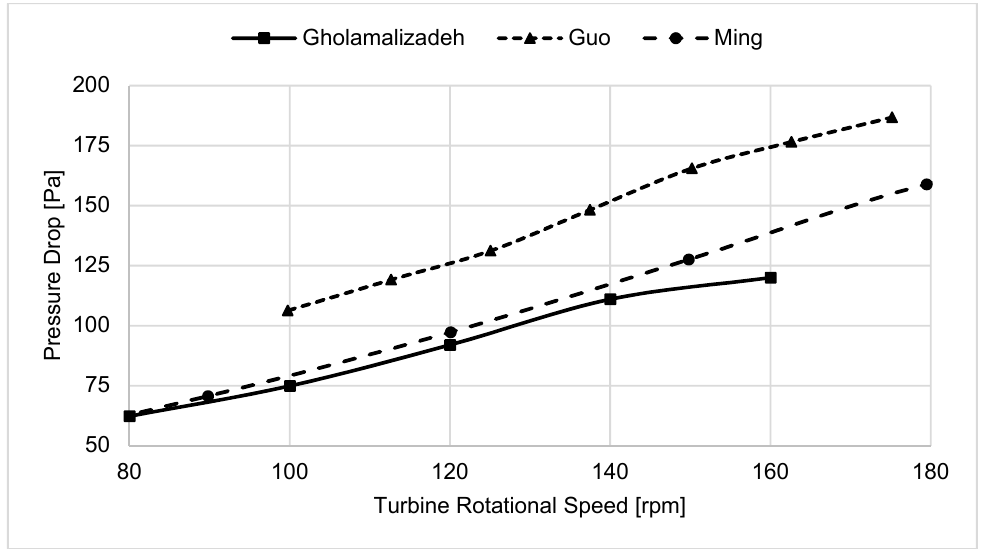
Figure 4. Pressure drop across the turbine at different turbine rotational speeds.